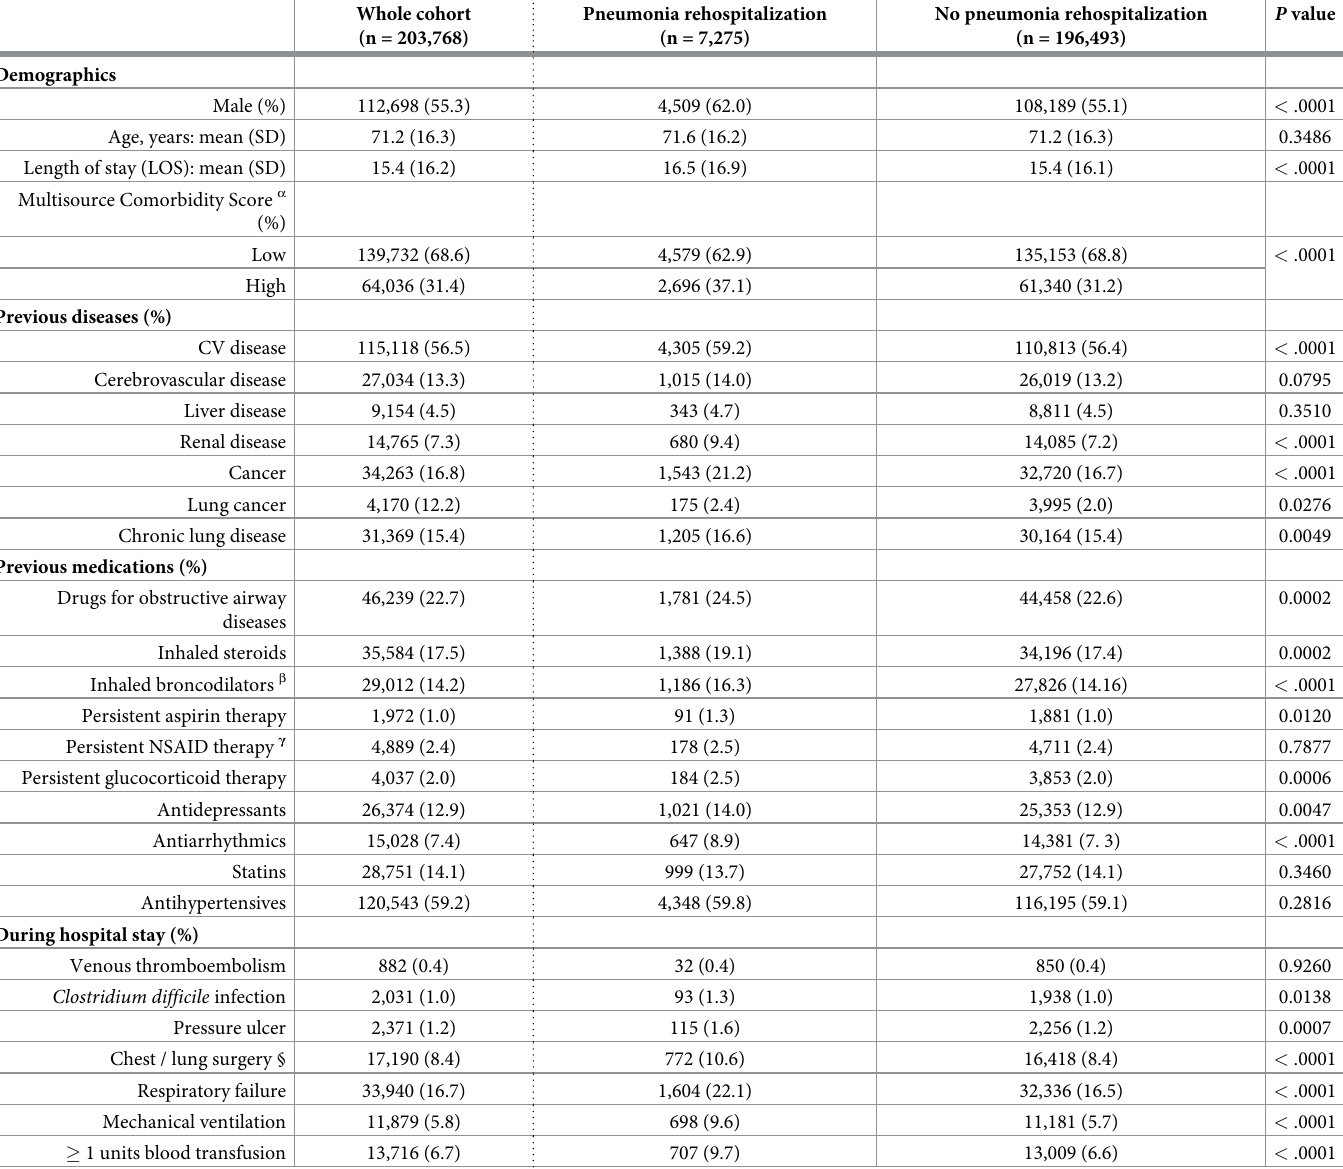
Table 1. Baseline demographic and clinical characteristics and therapeutic regimens of the 203,768 patients considered in the study, in the whole cohort and according to whether they experienced the outcome of interest. Lombardy, Italy,